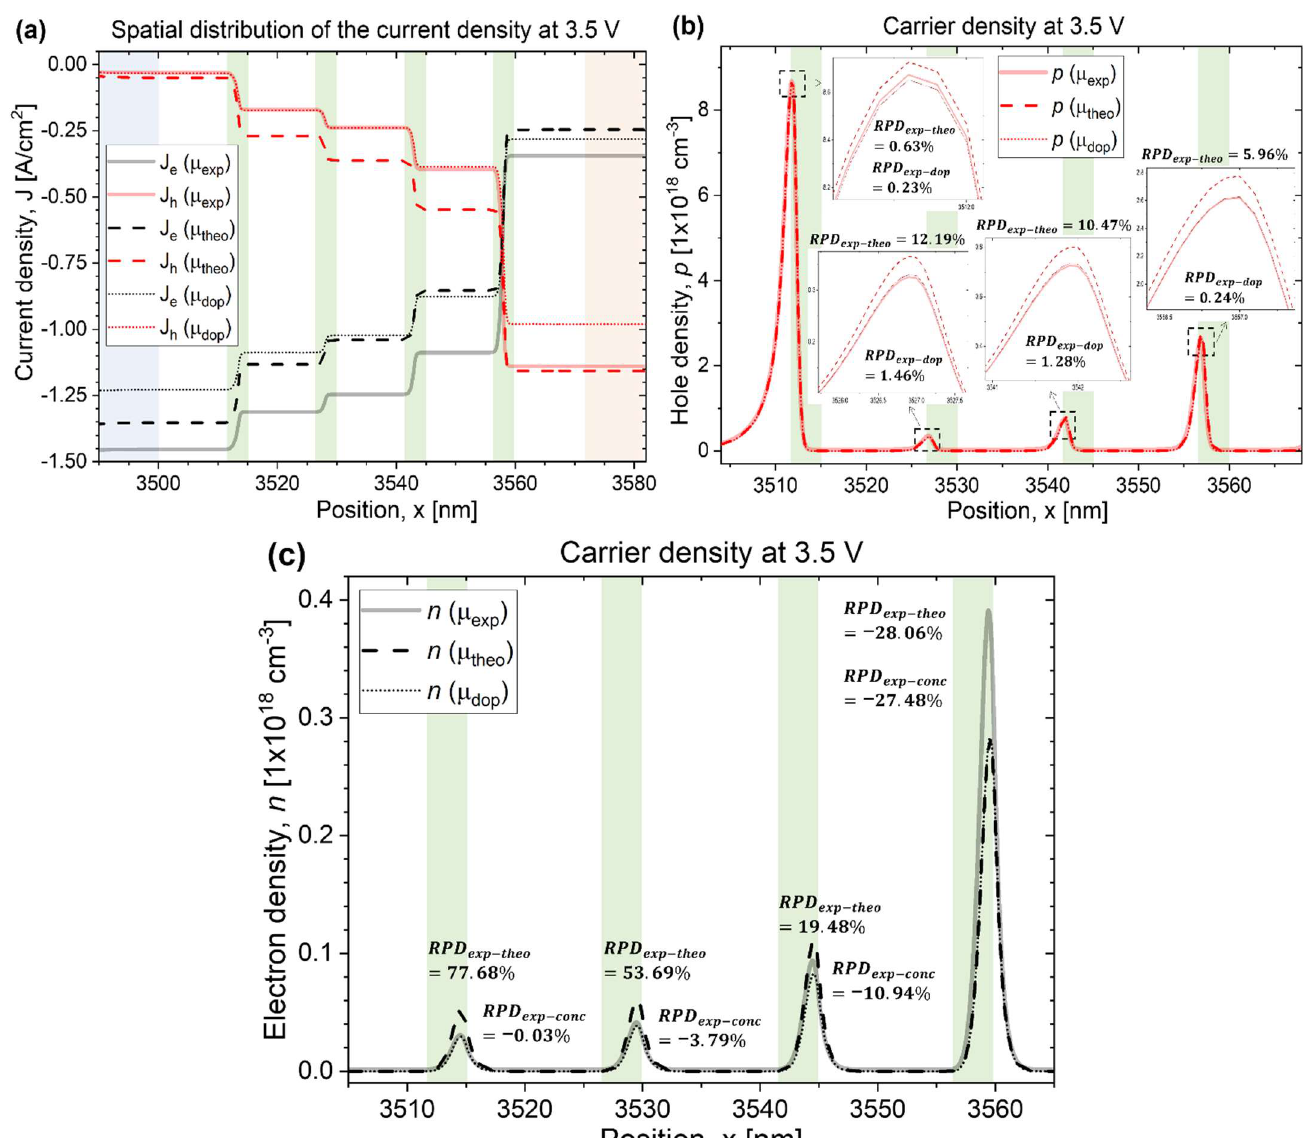
Figure 7. ( a ) Spatial distribution of current density; ( b ) hole and ( c ) electron density in the active layer of the LED at 3.5 Volts.